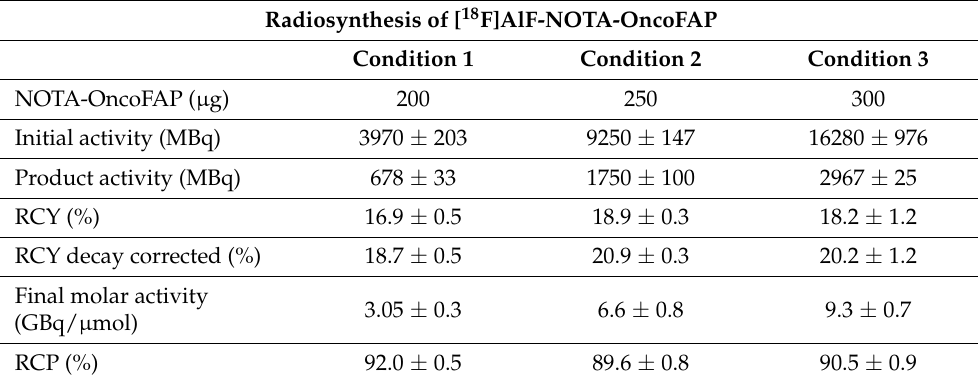
Table 7. Different conditions used for the synthesis of [ 18 F]AlF-NOTA-OncoFAP. Radiosynthesis of [ 18 F]AlF-NOTA-OncoFAP Condition